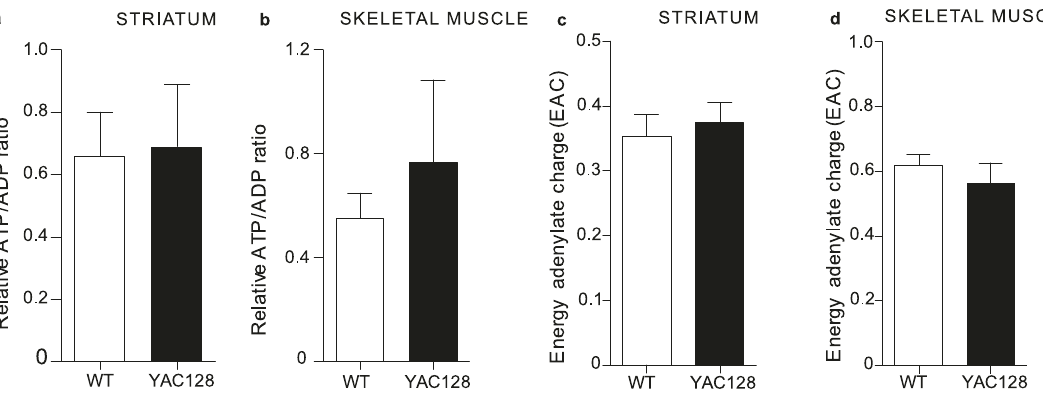
Fig. 5 ATP production is unaltered in the YAC128 mice compared to WT mice at 12 months of age. Genotype has no effect on the ATP synthase activity as measured by relative ATP/ADP ratio values in a striatum and b skeletal muscle using etheno derivatization/HPLC or on the levels of total mass of adenylate nucleotides (TAN) in c striatum or d skeletal muscle. Data are presented as mean ± s.e.m. WT n = 6; YAC128 n = 9. Unpaired two-sided t test was used for statistical